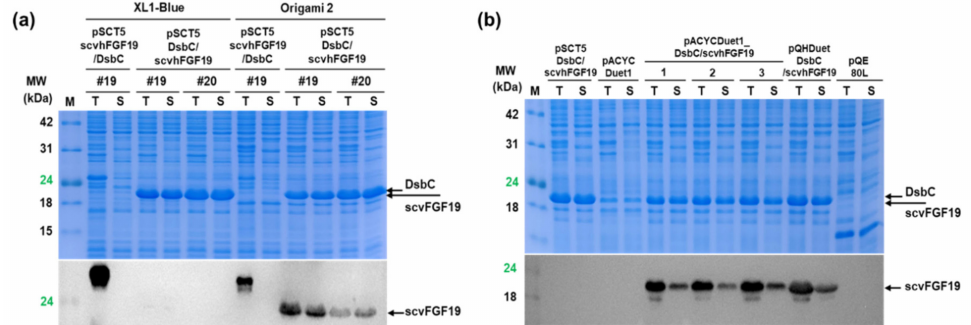
Figure 4. Expression analysis of DsbC co-expressed codon variant hFGF19. ( a ) Codon variant hFGF19 and DsbC were independently co-expressed under a single promoter. In this experiment, two constructs were used: scvhFGF19 / ∆ ssDsbC and ∆ ssDsbC / scvhFGF19 (denote the genetically expressed order). Two hosts— E. coli XL1-Blue and Origami 2—were used to compare the expression patterns under different reduction conditions of the cytoplasm. The lower panel shows a Western blotting result of the expressed codon variant 19. For clearer comparison, codon variant 20 was used as a positive control. ( b ) Co-expression of codon variant 19 and DsbC under two identical and different promoters in E. coli Origami 2 and Origami (DE3) were analyzed. pACYCDuet1 and pQE80L empty vectors were used as negative controls. Lanes 1–3: repeated experimental results of the clones harboring pACYCDuet1_ ∆ ssDsbC / scvhFGF19 under two identical T7 promoters; pQHDuet_ ∆ ssDsbC / scvhFGF19: the expression of DsbC and scvhFGF19 under T5 and T7 promoters, respectively. Arrows indicate the protein size corresponding to their prediction molecular weight: DsbC (23.5 kDa), scvhFGF19 (22 kDa). SDS-PAGE results for DsbC and scvhFGF19; overlapped bands were